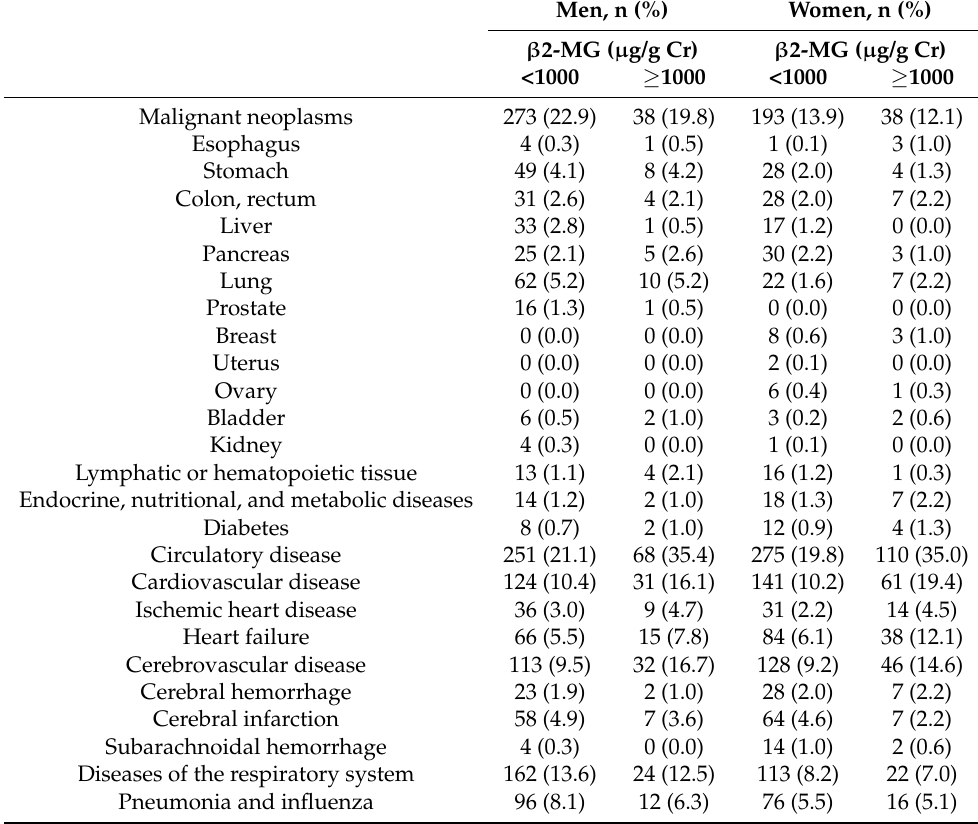
Table 2. Cause of mortality by sex and the urinary β 2-MG